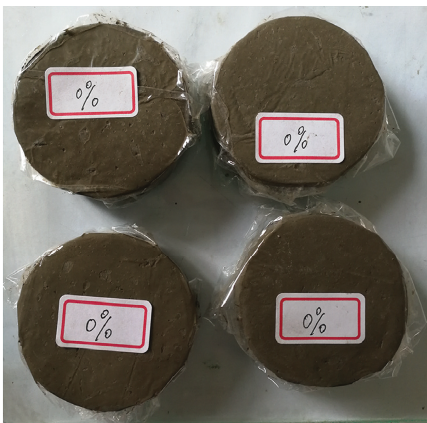
Figure 3: Iron ore tailings direct shear